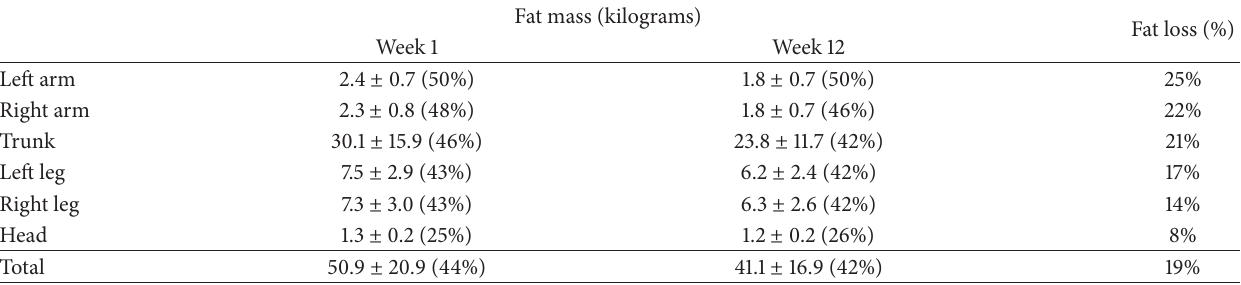
Table 2: Changes in fat mass before and after weight loss ( 𝑛 = 8 ).